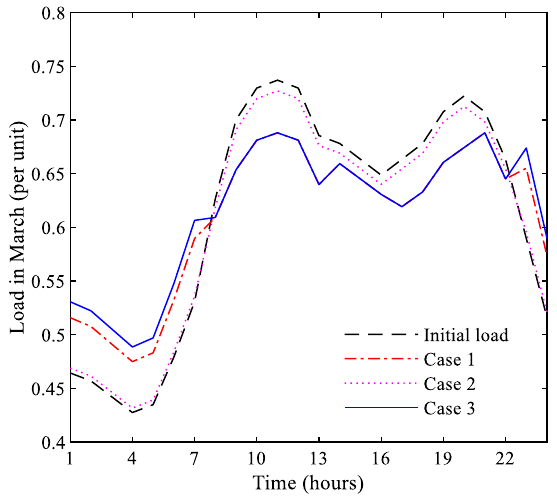
Fig. 9 Load curve of different types of users under TOU